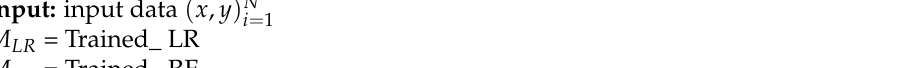
Algorithm 1 Ensembling of Logistic Regression and Random Forest Classifier (LRRF).